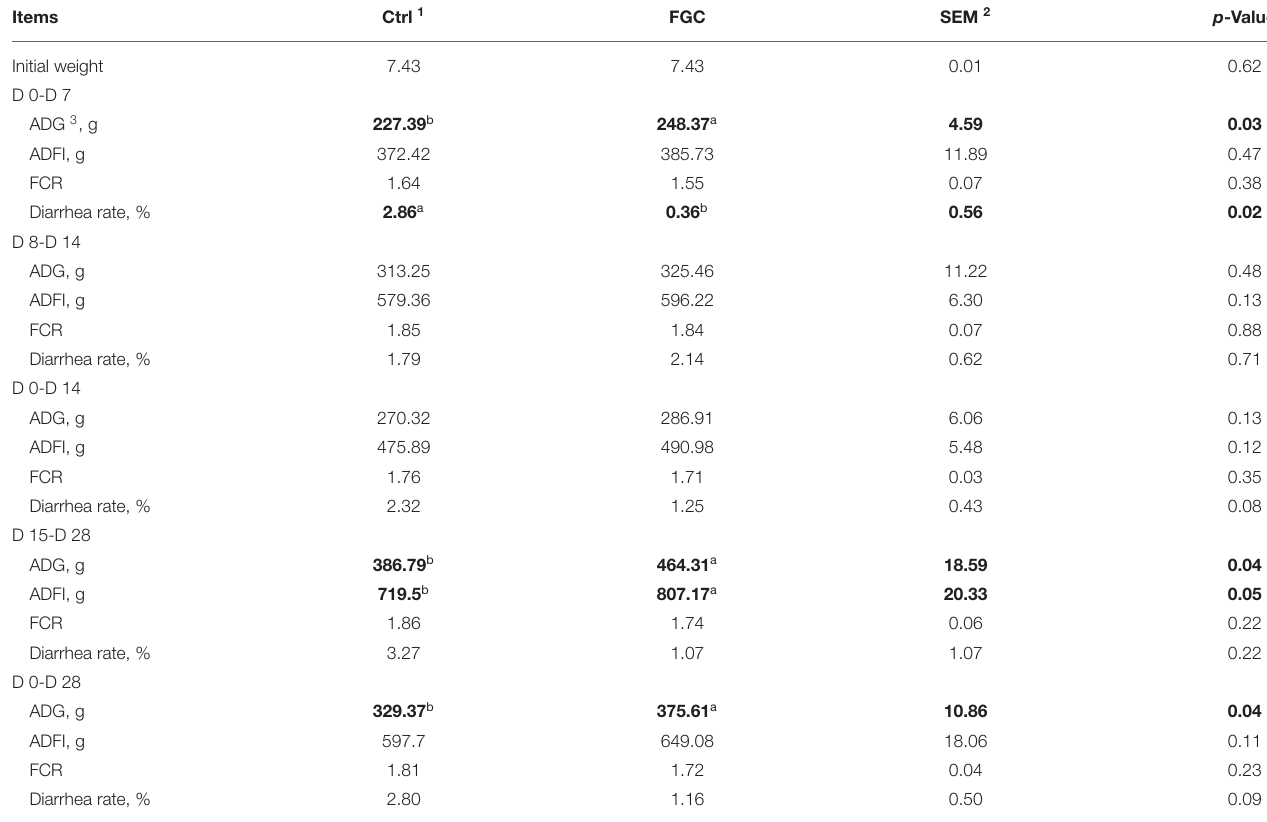
TABLE 1 | Growth performance of piglets as affected by dietary ferrous glycine chelate supplementation. Items Ctrl 1 FGC SEM